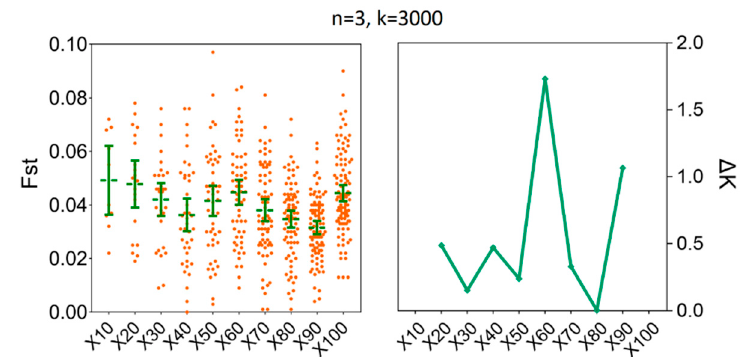
Figure 7. The minimum number of resampling replicates (x) required to estimate Fst between LNSY and PLKK populations . Bars represent sample means and 95% confidence intervals of the means. The Δ K ( Y -axis) shows a clear peak at the optimal replicates (x). Fst , pairwise genetic differentiation.